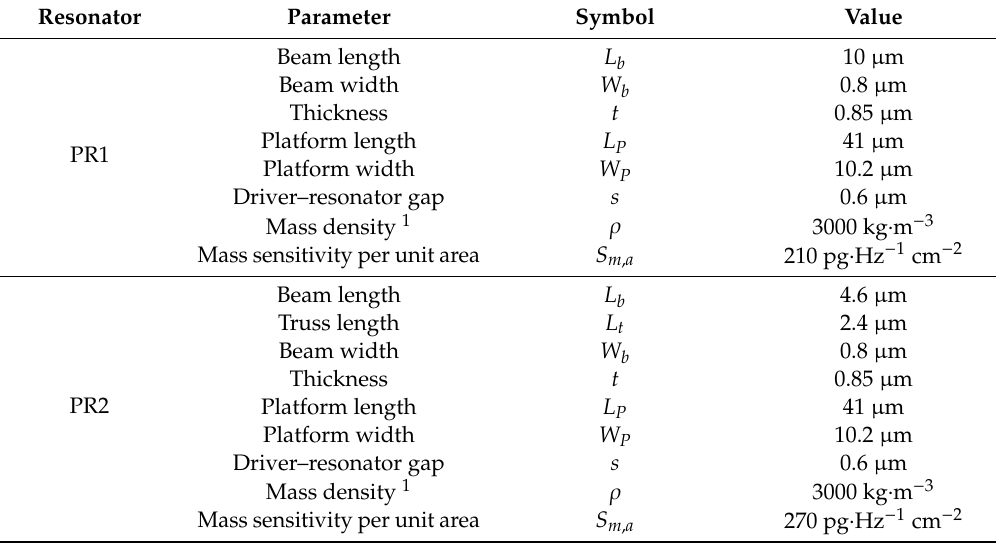
Table 1. Resonator fabrication parameters and computed mass sensitivity per unit area.